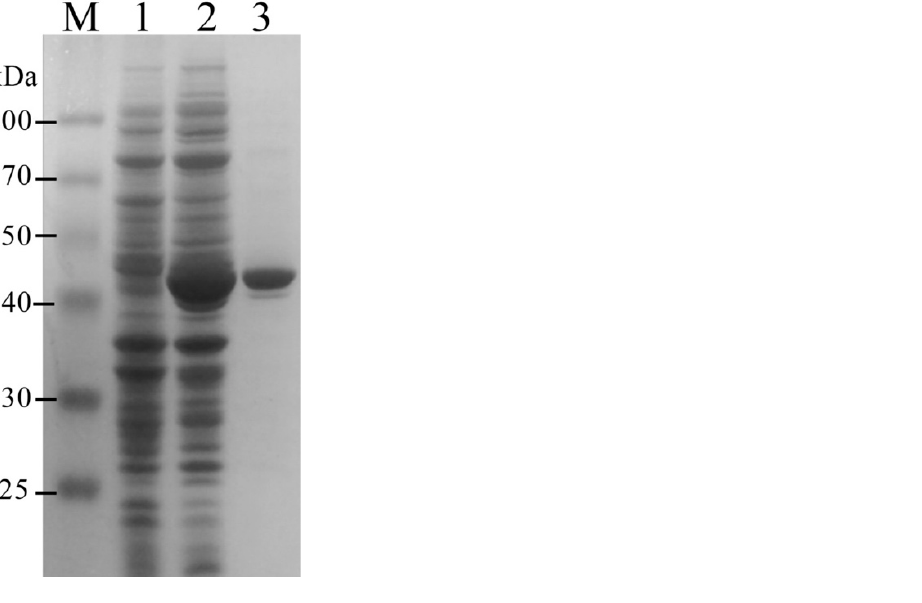
Figure 3. SDS-PAGE analysis of recombinant Pb LeuDH. Lane M, protein marker; Lane 1, crude enzyme extract of E. coli (pET28a); Lane 2, crude enzyme extract of E. coli (pET28a- Pbleudh ); Lane 3, purified Pb LeuDH. Table 1. Pb LeuDH activity toward L-leucine before and after